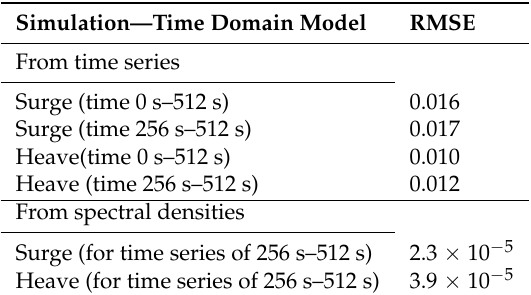
Table 3. Root mean squared error (RMSE) of the two time series comparison; the computational and the measured experimental data (presented in Figures